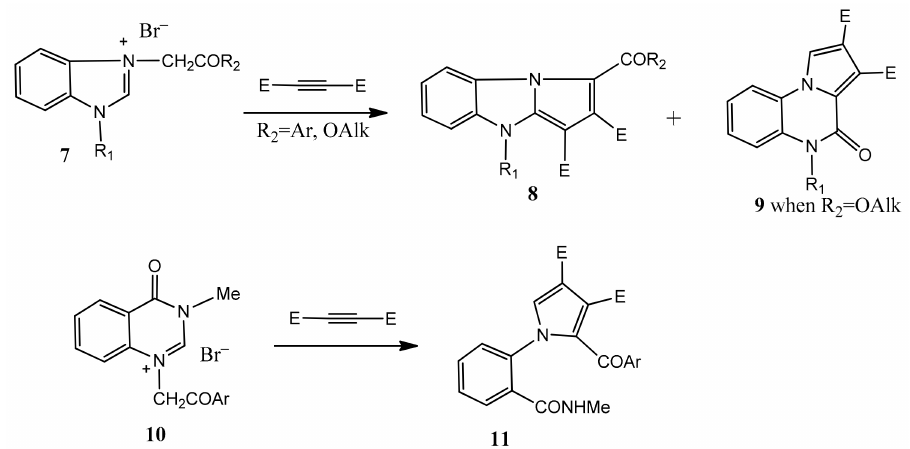
Scheme 2. Polysubstituted pyrrole structures starting from different cycloimmonium